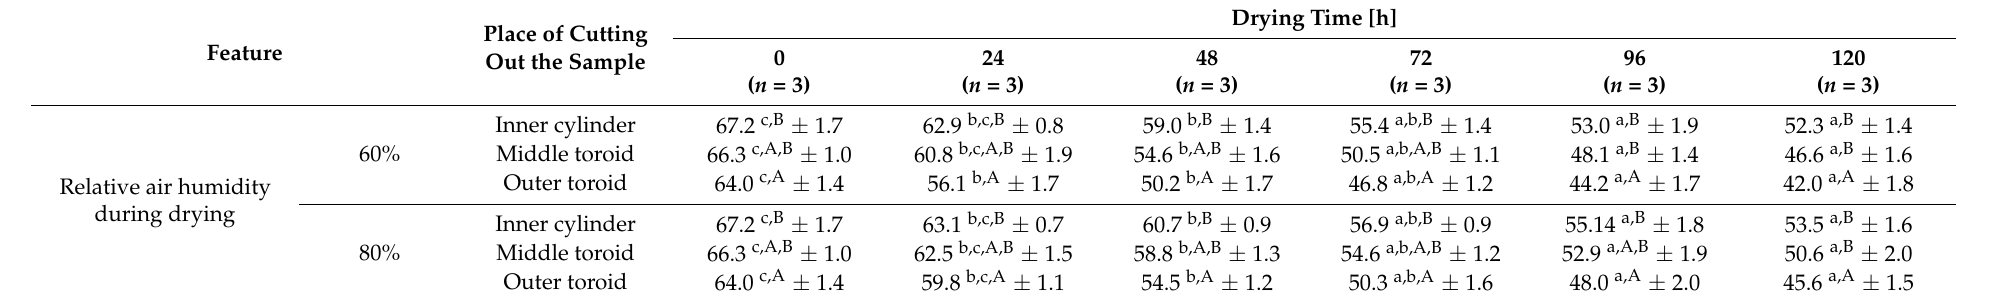
Table 4. Changes in water content in KSS sausages during the drying process (mean ± standard